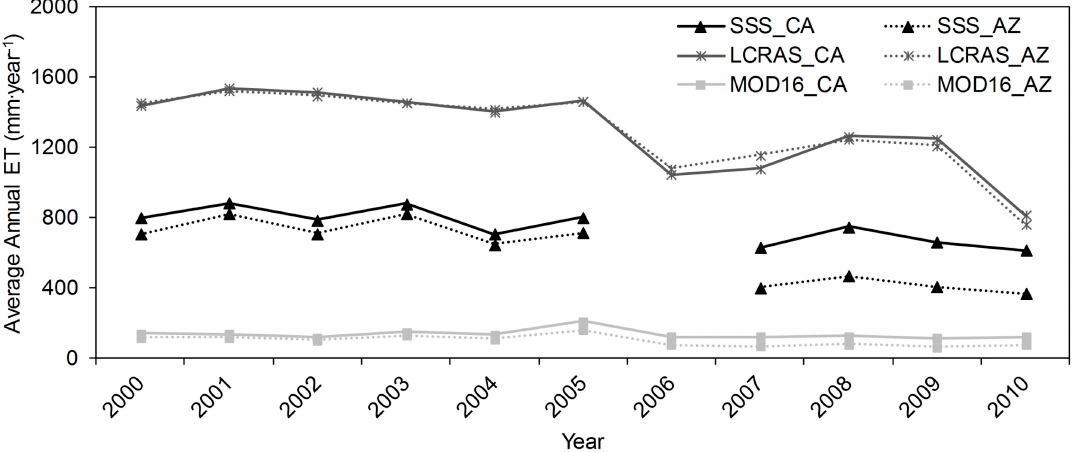
Figure 9. Comparison of annual ET over the California (CA) (solid) and Arizona (AZ) (dotted) regions of the CNWR. SSS-ET was not estimated for 2006 due to wildfire.